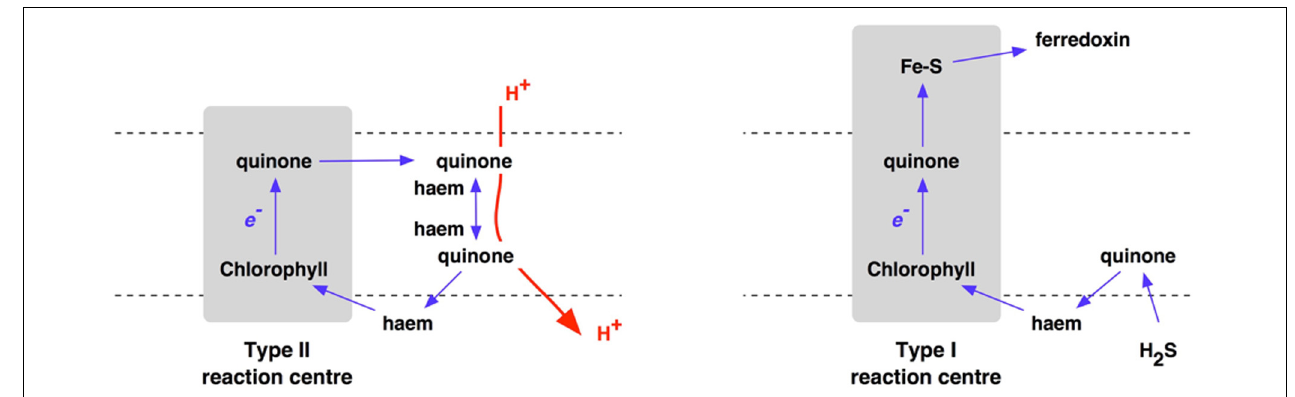
FIGURE 2 | Electron transport chains incorporating either Type II (left) or Type I (right) reaction centers of anoxygenic photosynthesis.